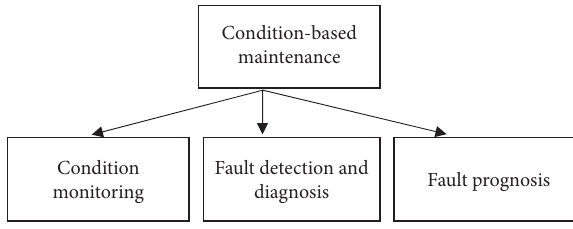
Figure 1: The main components of